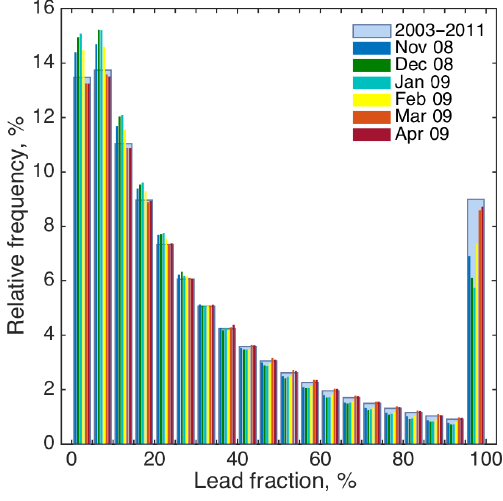
Figure 1. Histogram for the AMSR-E lead fraction (LF) data set shown as the number of measurements per each LF bin of 5% width expressed in percent of the total number of measurements (relative frequency). The blue bars show the full data set, while each month of the winter 2008–2009 is shown by other colours (see the